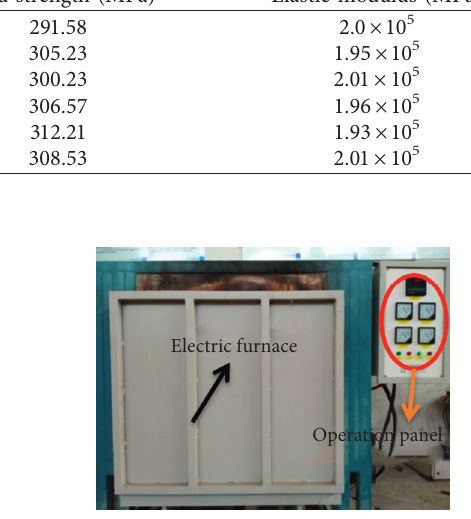
Figure 4: Elevated temperature experimental furnace.